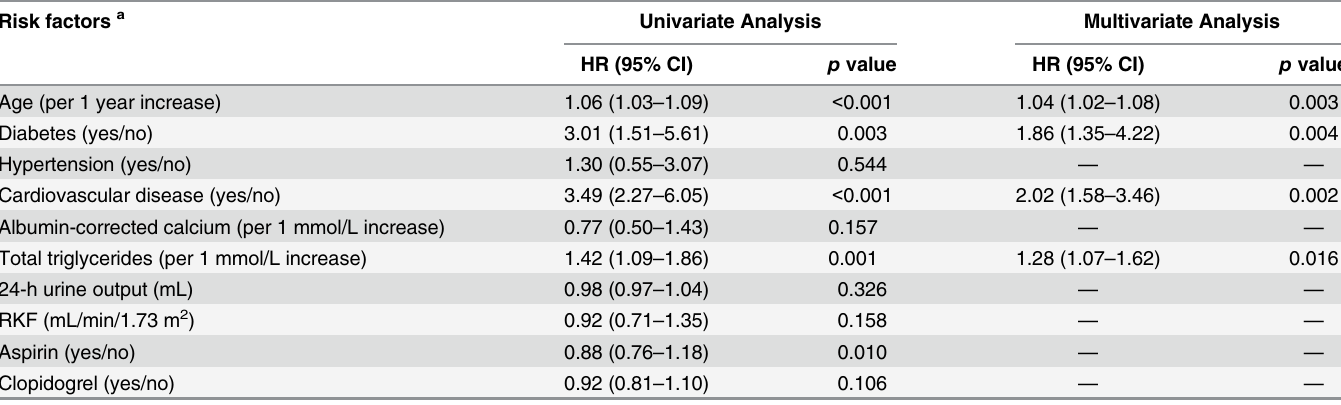
Table 7. Risk factors for stroke in peritoneal dialysis